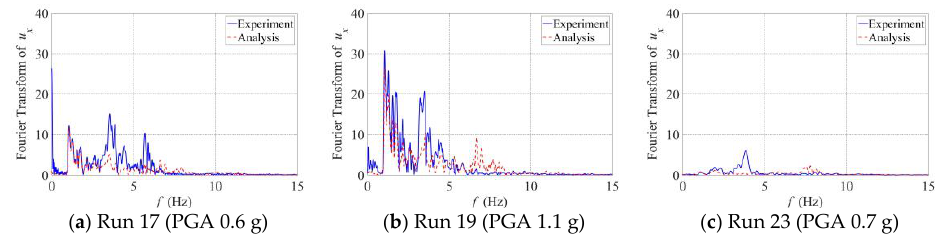
Figure 31. Frequency spectrum of the x directional displacement at point A on the third floor.